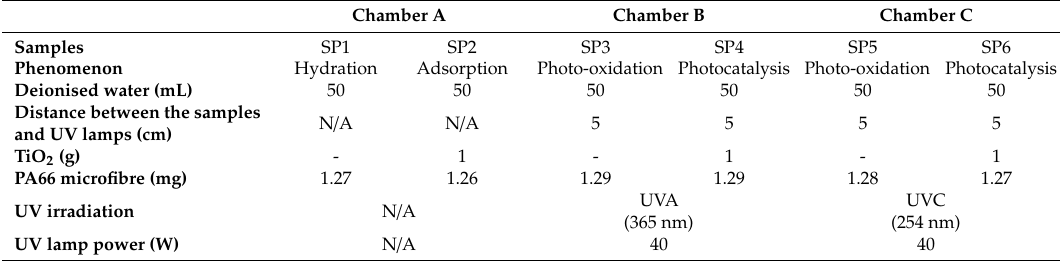
Figure 4. Prepared PA66 microfibre samples immersed in 50 mL of deionised water in Petri dishes placed in each chamber ( A ), ( B ), and ( C ). SP1, SP3, and SP5 did not include TiO 2 , and SP2, SP4, and SP6 contained 1g of TiO 2 each. SP is refers to sample. Table 1. Conditions applied to the samples (SP1 to SP6). A triplicate study was carried out for each condition.